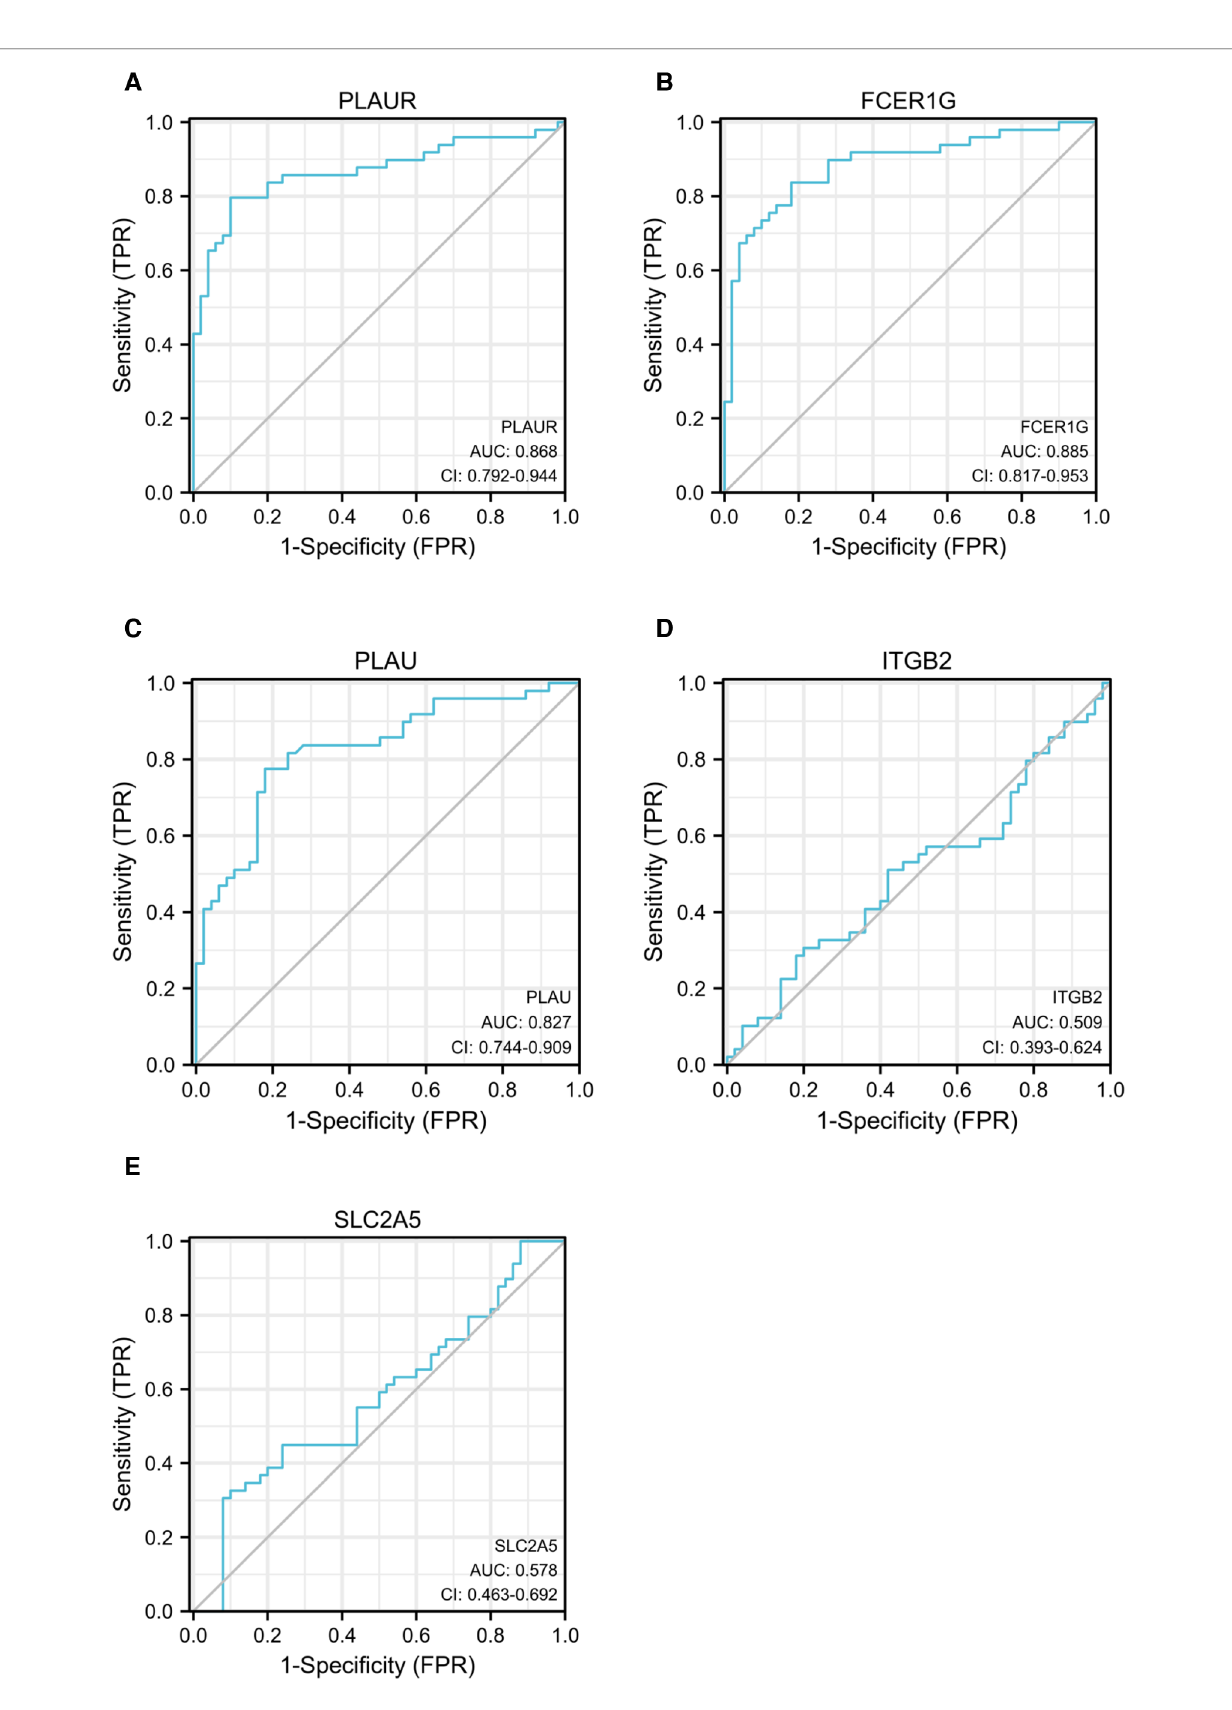
FIGURE 11 ROC curves of PLAUR ( A ), FCER1G ( B ), PLAU ( C ), ITGB2 ( D ), and SLC2A5 ( E ) to evaluate the ability of these genes to discriminate between AMI and control groups. ROC, receiver operating characteristic; AMI, acute myocardial